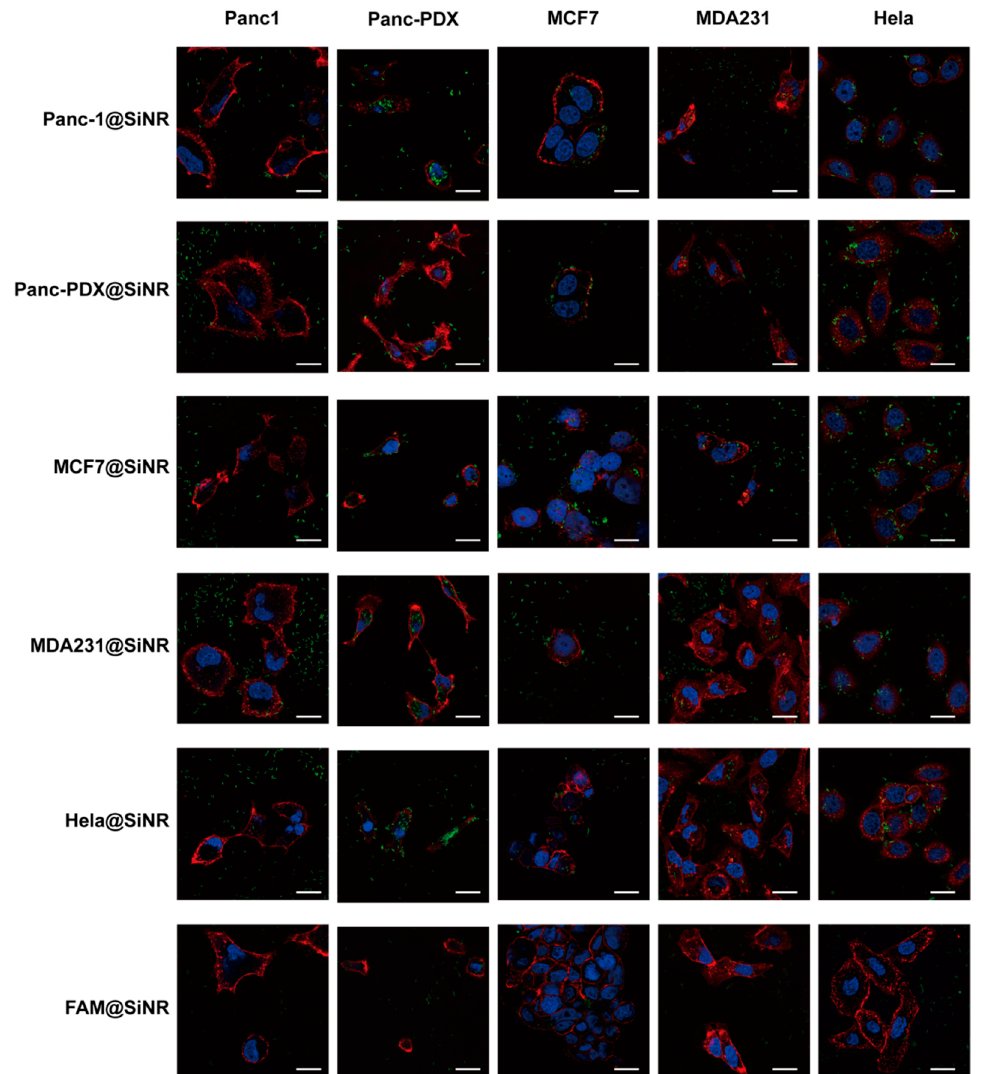
Figure 6. Cell morphology and SiNR location by confocal laser microscopy. The SiNR with FAM (green), cell nucleus stained with Hoechst (blue), Alexa ‐ 594 conjected WGA staining cell membrane (red) were observed. The scale bar in white stands for 20 μ m. The FAM only linked SiNR was used as a control.